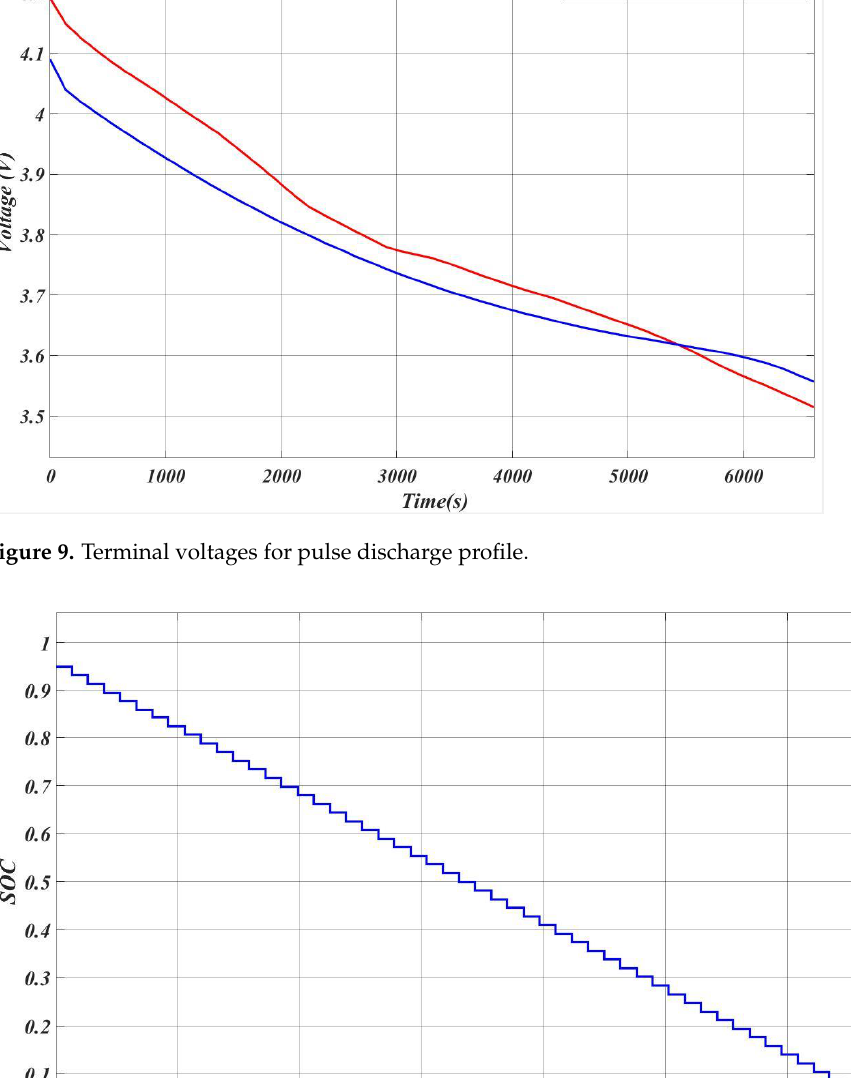
Figure 8. Voltage response, current and the SOC range of Li polymer cell.